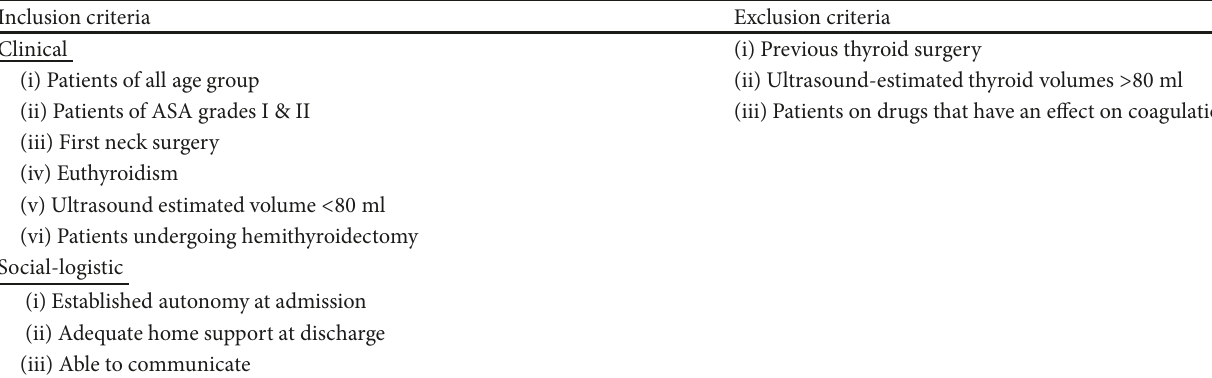
Table 1: Inclusion and exclusion criteria